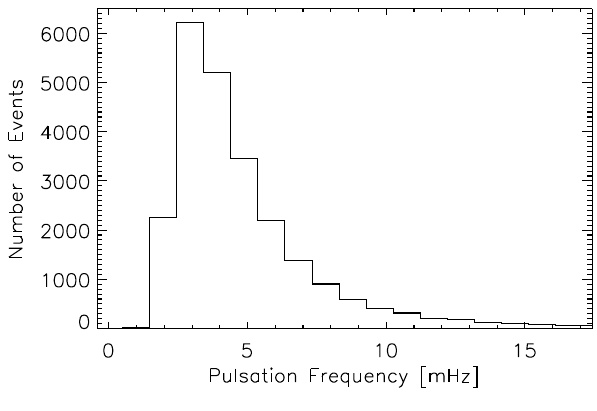
Fig. 4. Distribution of events in local time of the center point of the station distribution involved in the analysis of each event taken at the mean time of appearance of the pulsation. Binning used for the histogram: half an